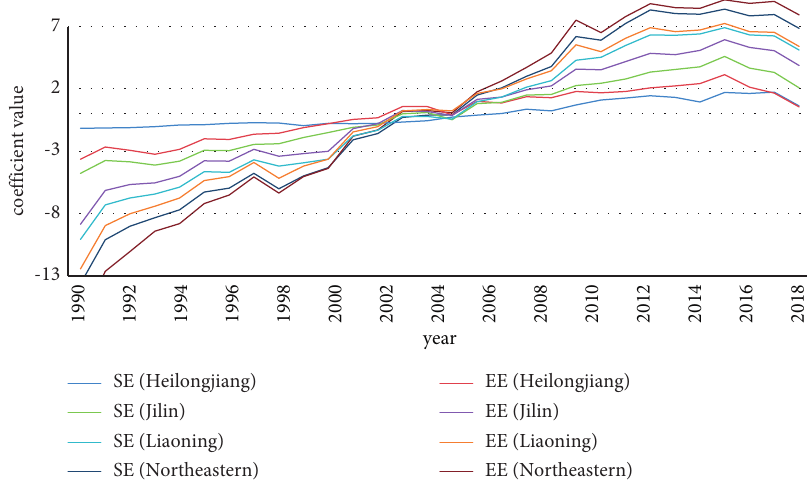
Figure 1: Comprehensive developmental levels of SE and EE subsystems in Northeastern China from 1990 to